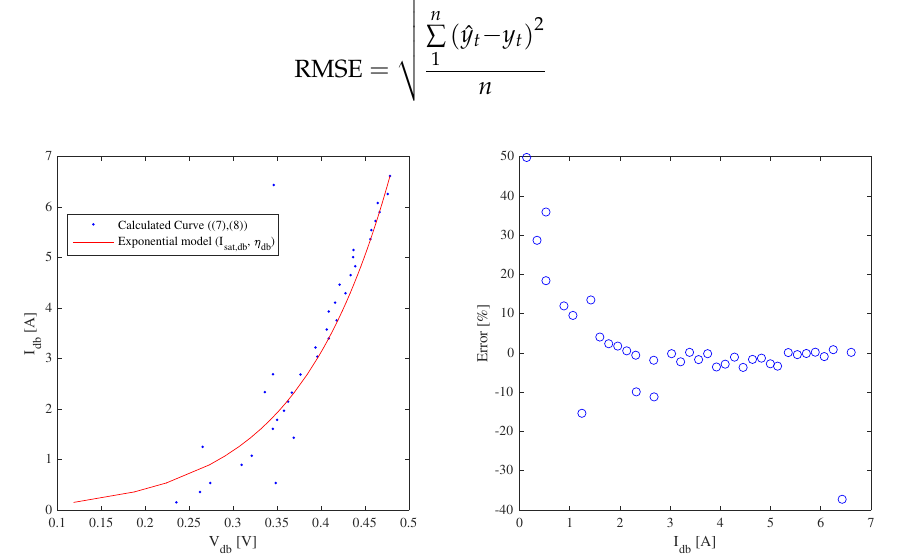
Figure 13. Left : Experimental (dots) and reproduced (line) I-V curve of the bypass diode in submodule 1 for high irradiance level. Right : percentage errors of the bypass diode voltage.